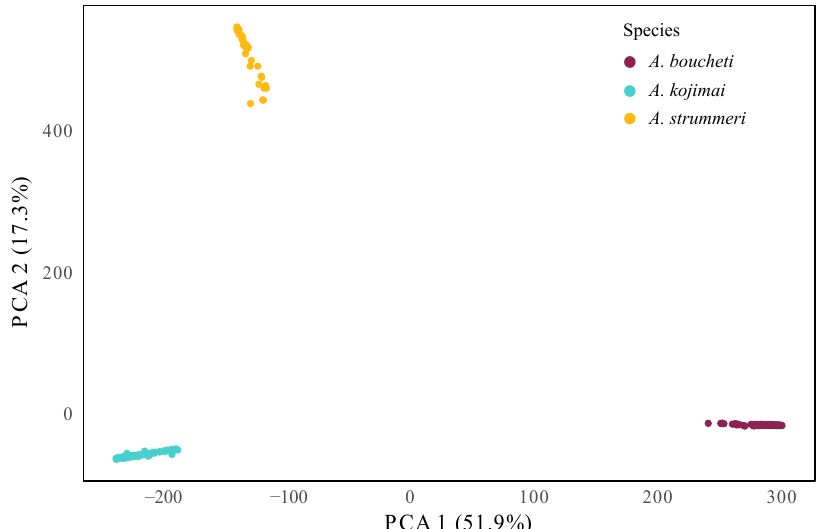
Figure 6. Principal component analysis of multilocus genotypes using 60,084 SNPs across 498 indi- viduals of Alviniconcha spp. Purple: A. boucheti , turquoise: A. kojimai , and yellow: A. strummeri.